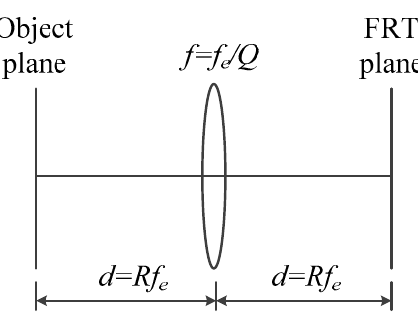
Figure 2. Lohmann type-I optical setup for performing a FRT.